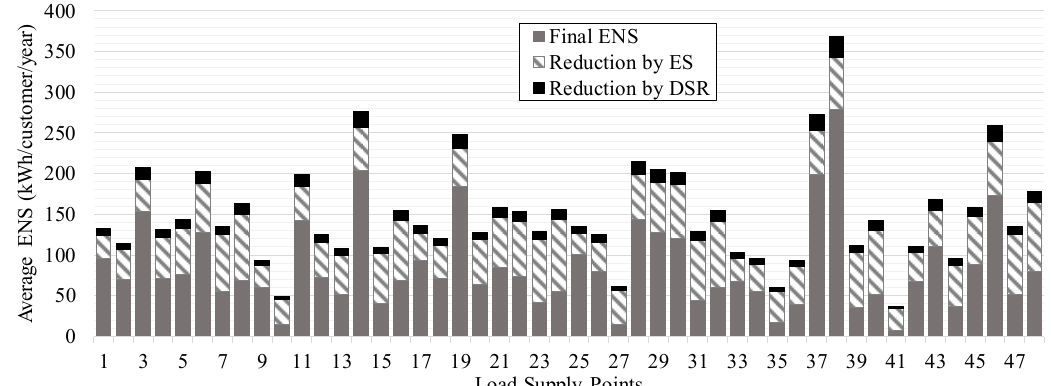
Figure 17. Average ENS for different load supply points.